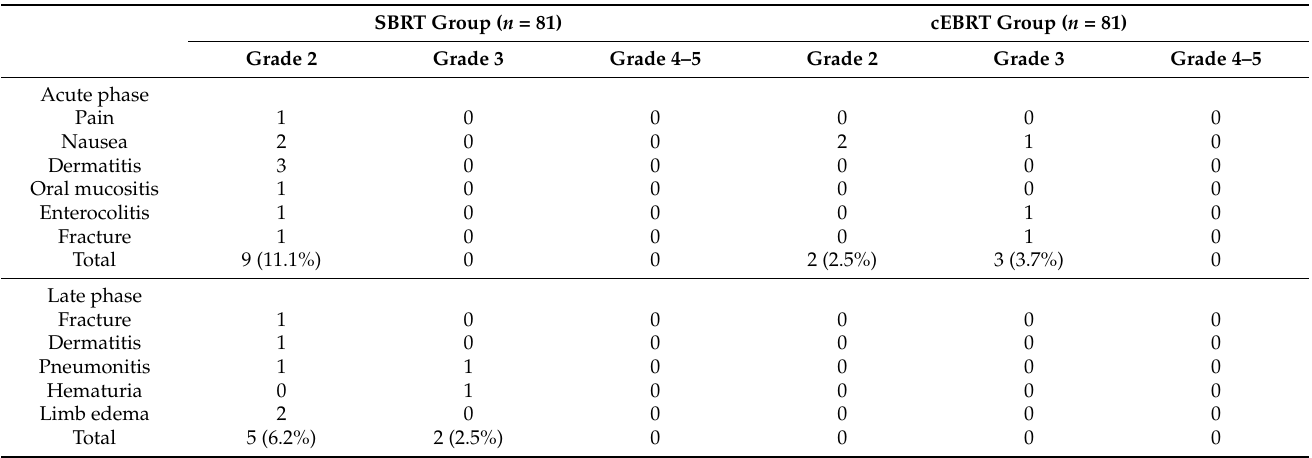
Table 3. Adverse effects of radiotherapy in the PSM